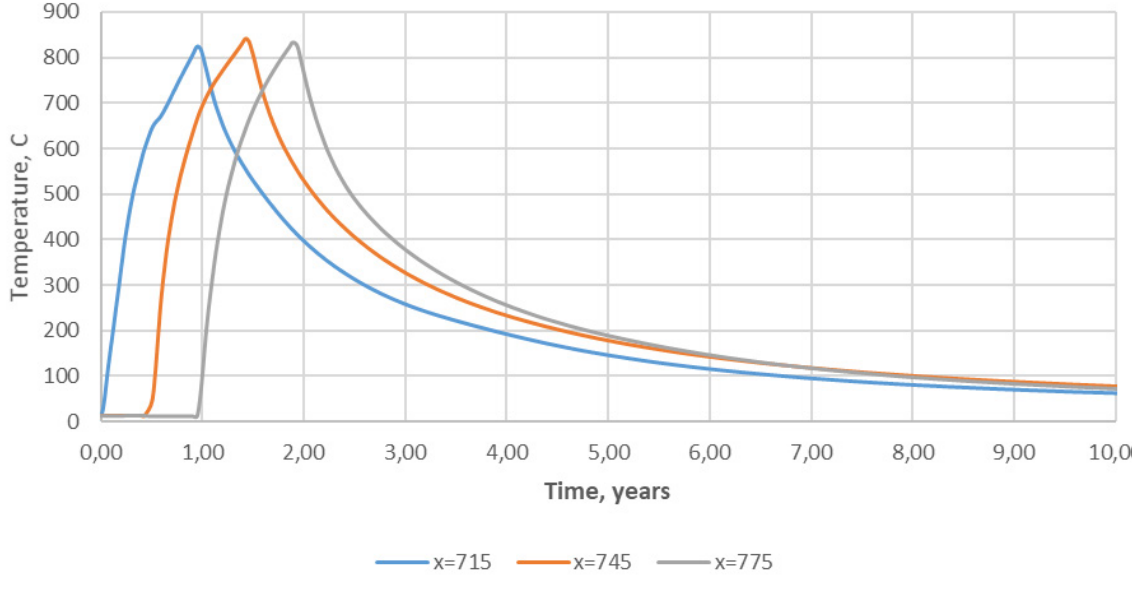
Figure 5: Evolution of temperature at selected points of the gasified